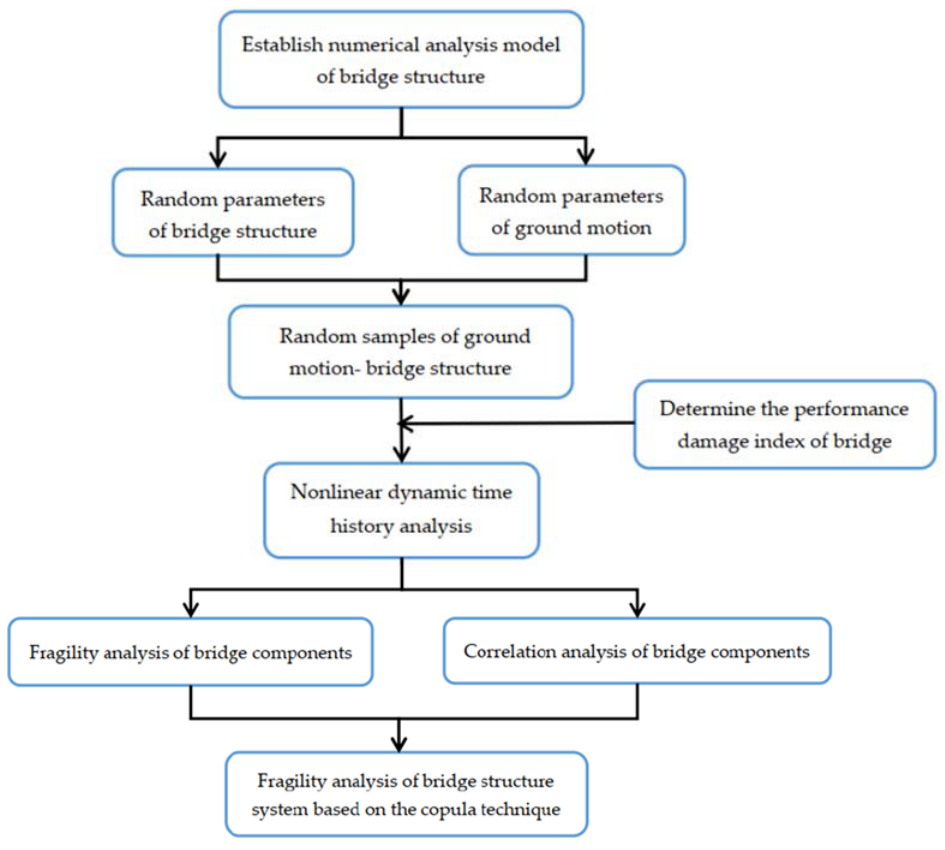
Figure 1. The technical route of the research process.